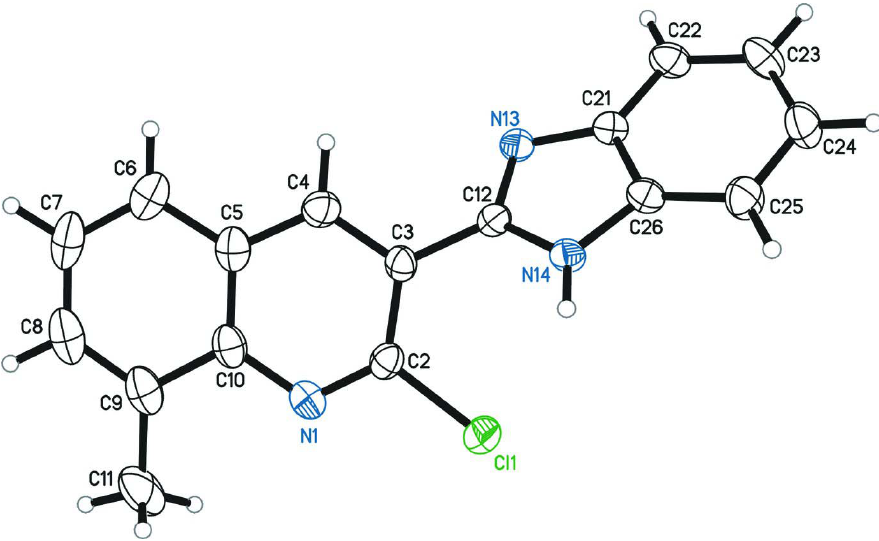
Thermal ellipsoid representation of the title compound with displacement ellipsoids plotted at 50% probability level. Only one of the two independent molecules is